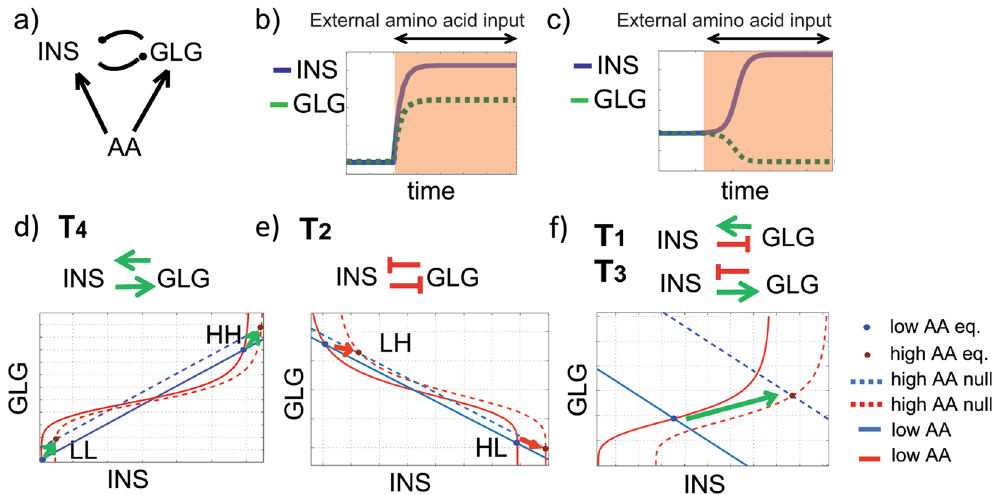
Figure 4. Circuit responses to amino acid inputs. ( a ) Amino acids (AA) stimulate the secretion of both insulin and glucagon. ( b ) Schematic example of coordinated behavior of insulin (blue line) and glucagon (green dashed line) over time after a step amino-acid stimulus (orange shaded area). ( c ) Schematic example of uncoordinated behavior of insulin (blue line) and glucagon (green dashed line) over time after a step amino-acid stimulus (red shaded area). ( d ) Schematics of nullclines for the T 4 circuit with a double positive interaction between the two hormones, without AA input (continuous lines) and with the AA input (dashed lines): intersections (dots) represent steady states (LL - HH). ( e ) Schematics of nullclines for the T 2 circuit with a double negative interaction between the two hormones without AA input (continuous lines) and with the AA input (dashed lines); intersections (dots) represent steady states (LH - HL). After the AA stimulus, nullclines shift and both steady states decrease (red dots). ( f ) Schematics nullclines for a negative feedback between the hormones (continuous lines); the intersection (dot) represents a single steady state; after the AA stimulus, nullclines shift (dashed lines) and both hormones increase